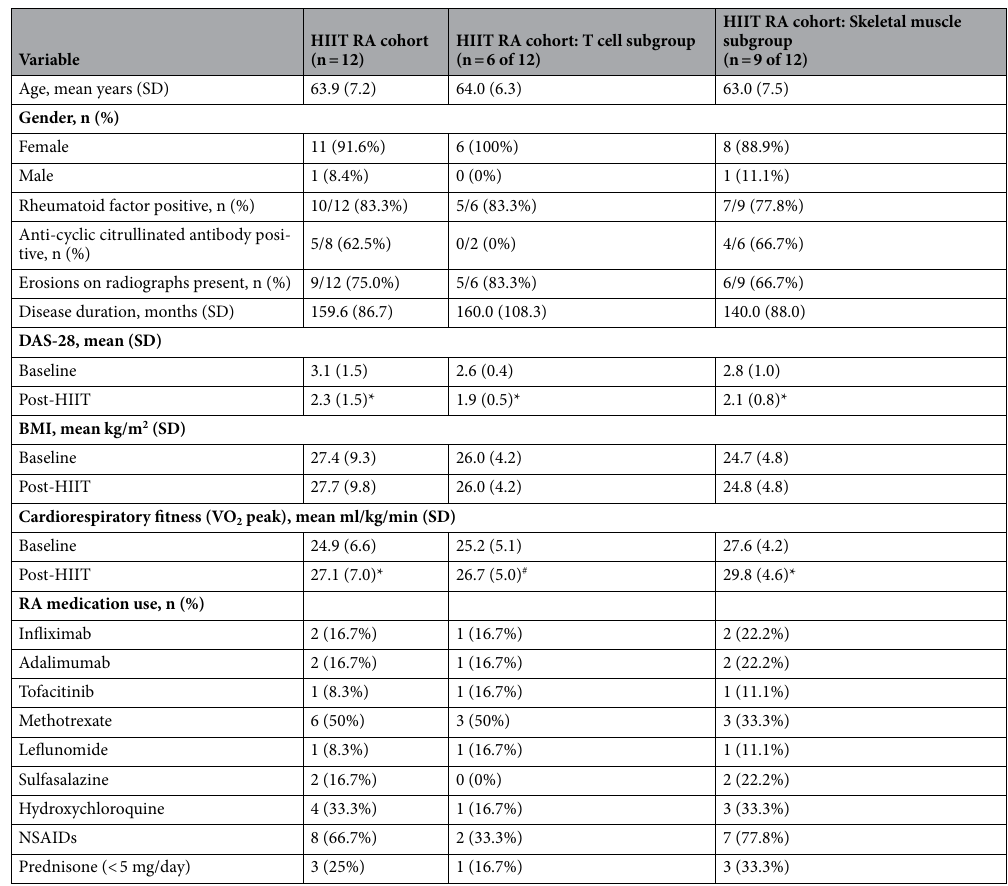
Table 1. Rheumatoid arthritis patient clinical characteristics. HIIT high intensity interval training, RA rheumatoid arthritis, DAS-28 disease activity score in 28 joints, BMI body mass index. *p < 0.05 for paired t-test comparisons between pre-HIIT and post-HIIT. # p = 0.05 for paired t-test comparisons between pre-HIIT and